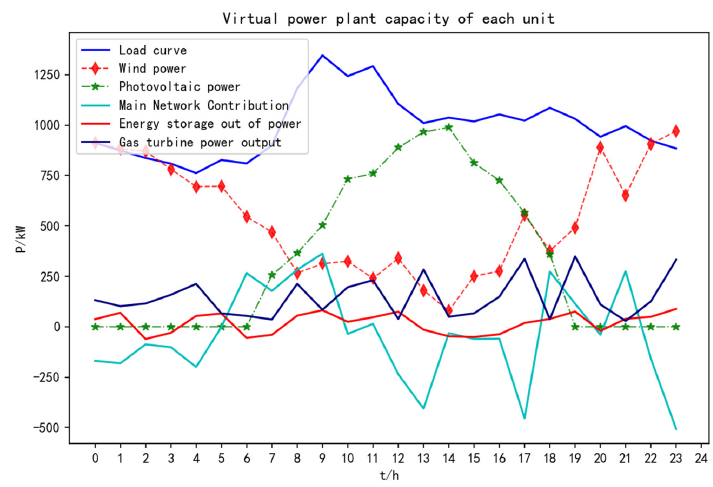
Figure 11. Capacity of VPP components without carbon trading.